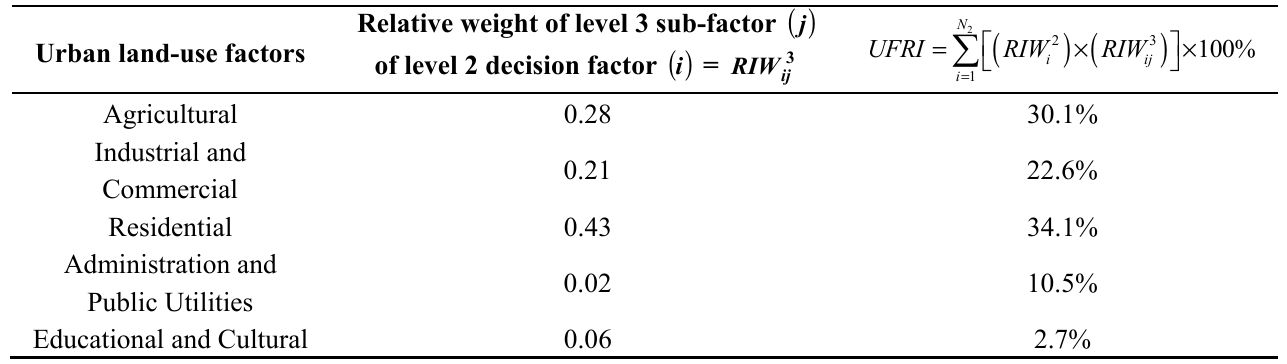
Table 6. Land-use flood risk index (FRI) within Eldoret